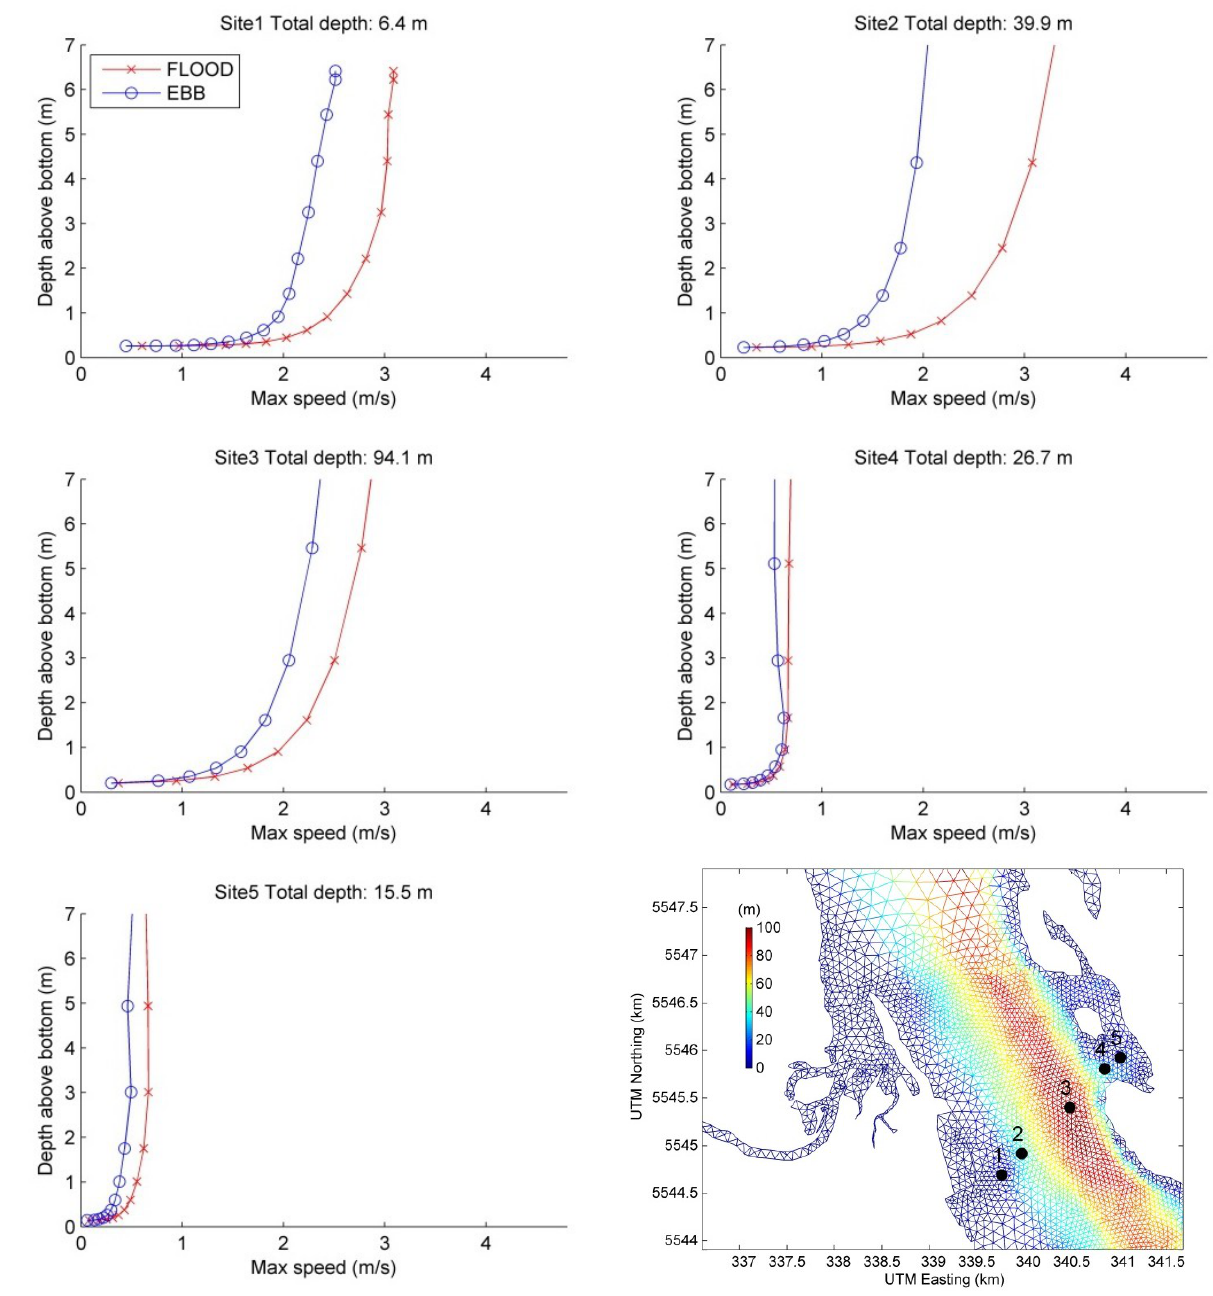
Figure 8. Near bottom vertical distribution of model derived maximum current speeds along the routes during flood (red lines) and ebb (blue lines) tides at the 5 sites marked in the bottom